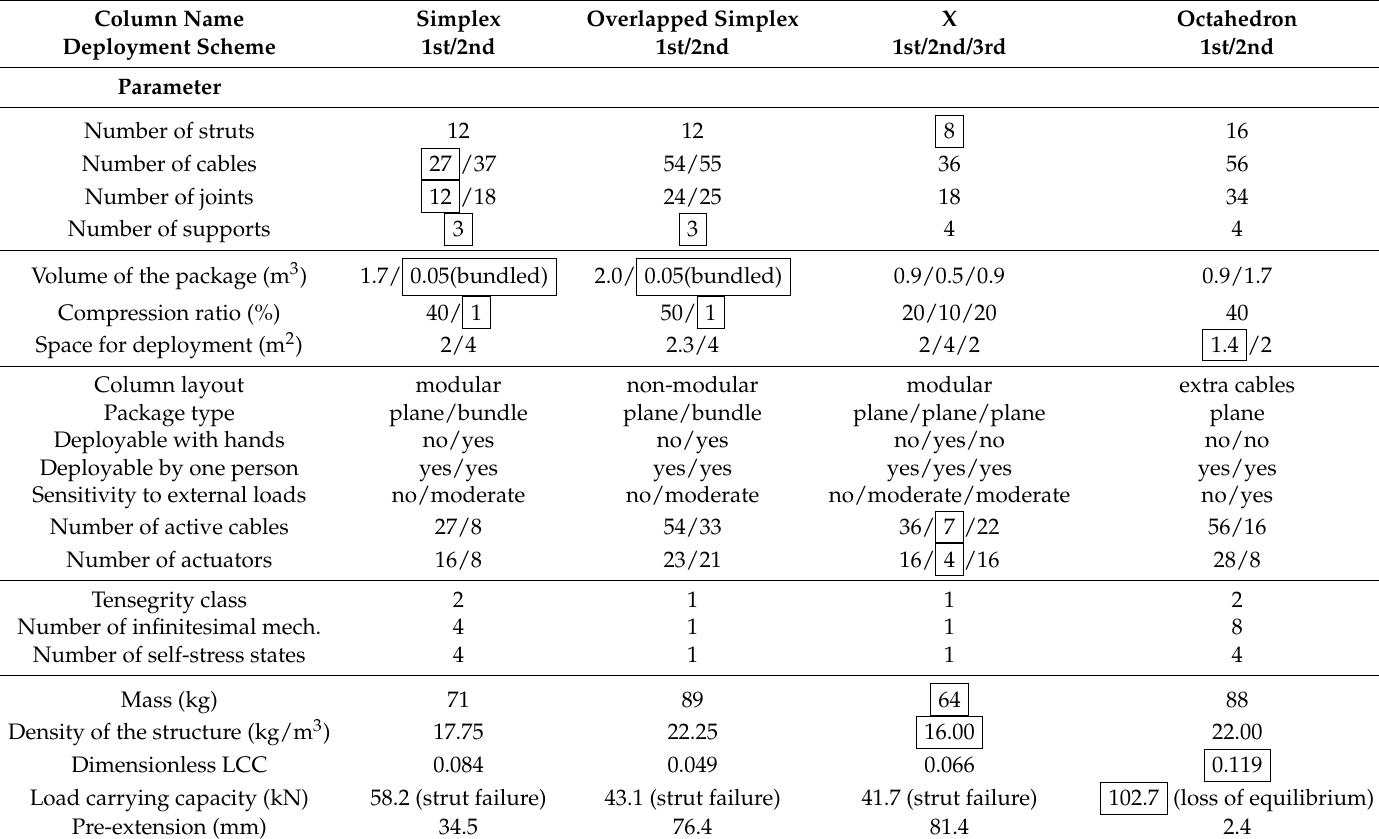
Table 6. Comparison of the columns